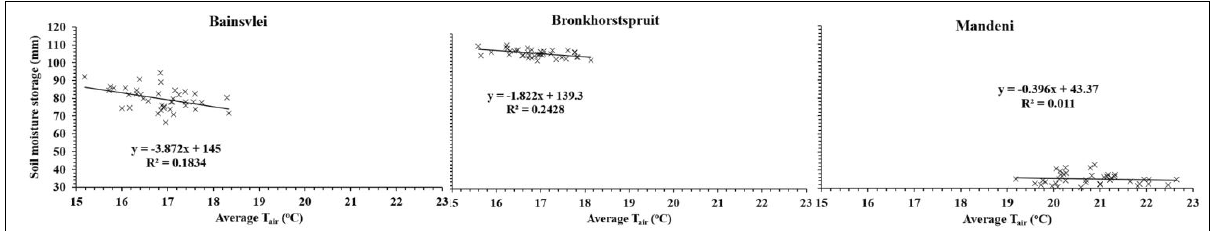
Figure 3: Regression plots of average annual air temperature ( T